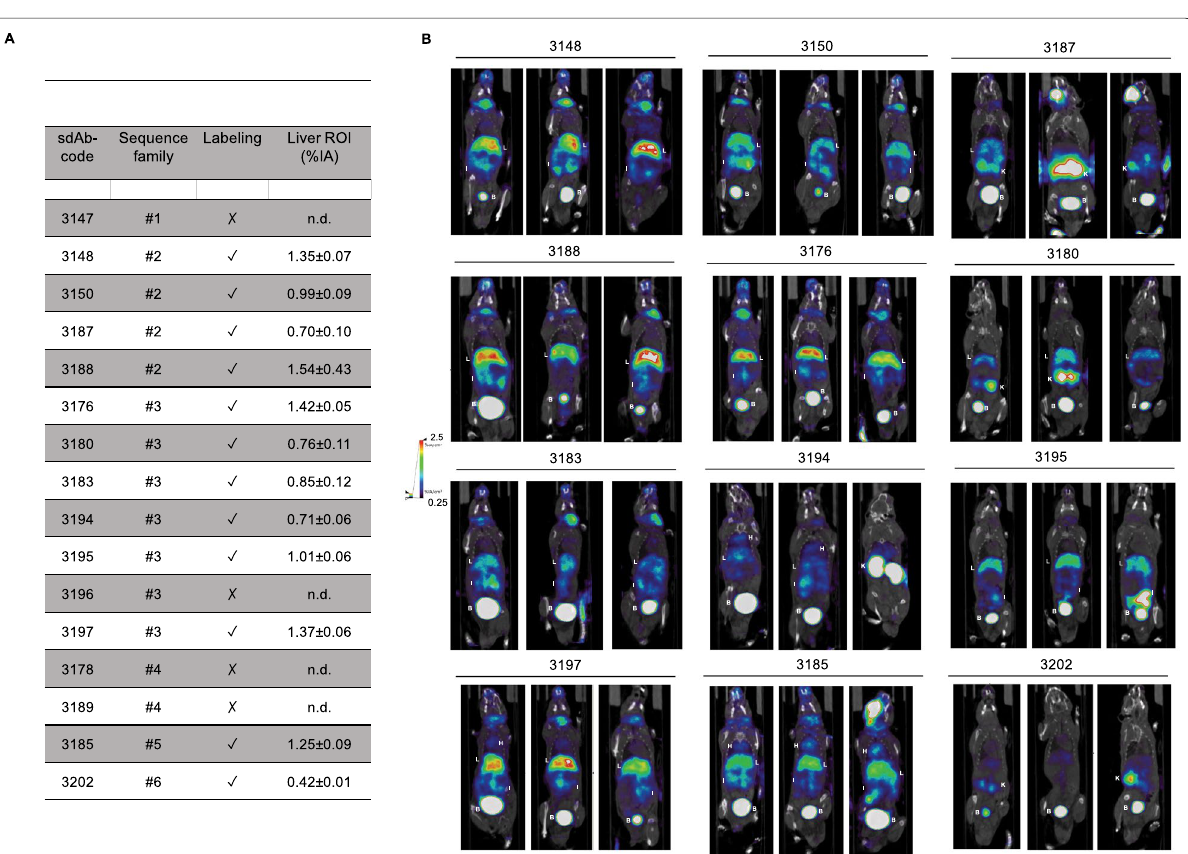
3). K kidney, L liver, H heart, I intestines, = = = = =